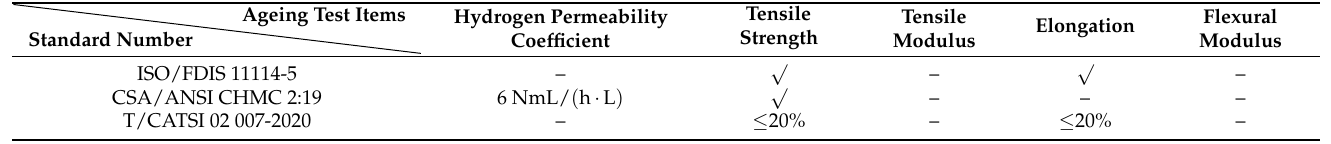
Table 10. Comparison of the acceptance criteria of ageing behaviors among the three existing